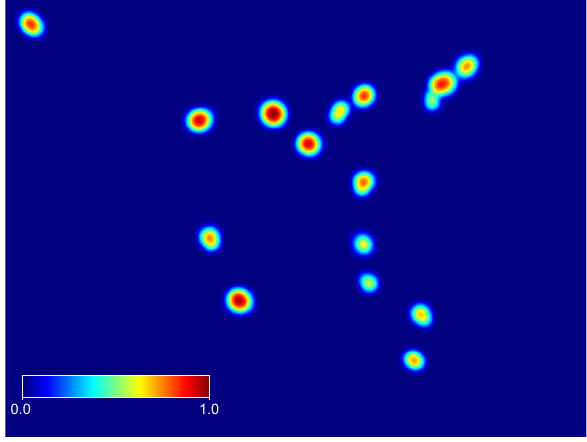
Figure 6. Illustration of selected steps of single image